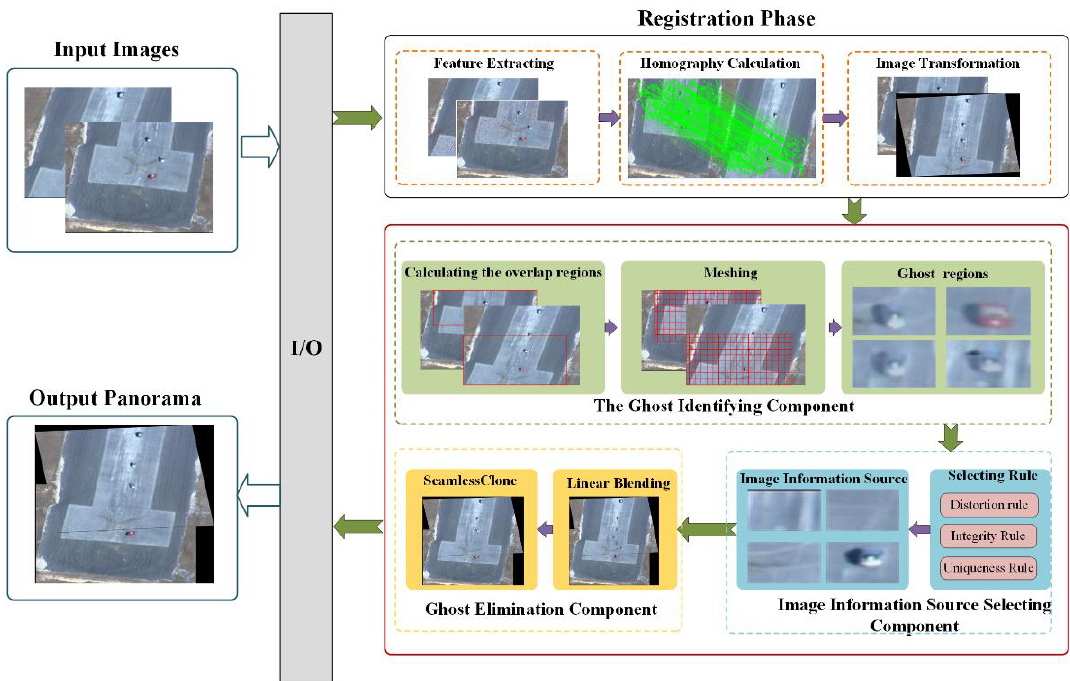
Figure 5. The overview of proposed method.